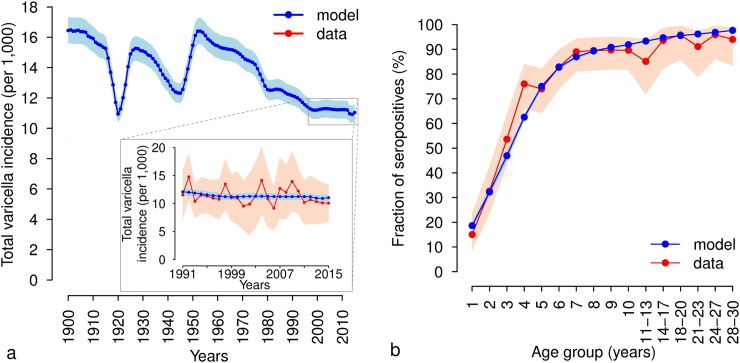
Epidemiological validation of Model M2.a Mean total incidence of varicella (per 1,000 individuals) as estimated by model M2 over the period 1900–2015. Shaded areas represent 95% CI of model estimates. The inset compares the total incidence of varicella predicted by the model in 1991–2015 (blue) to the one observed by the French GPs Sentinelles Network over the same period (red) [10]. Shaded areas represent 95% CI of model estimates (light blue) and of the data (orange). b Age-specific VZV seroprevalence as observed in data from France in 2003 [2] (red) and as estimated by model M2 (blue). Shaded areas represent 95% CI of the data as computed by exact binomial test in [2] (orange) and 95% CI of model estimates (light blue).